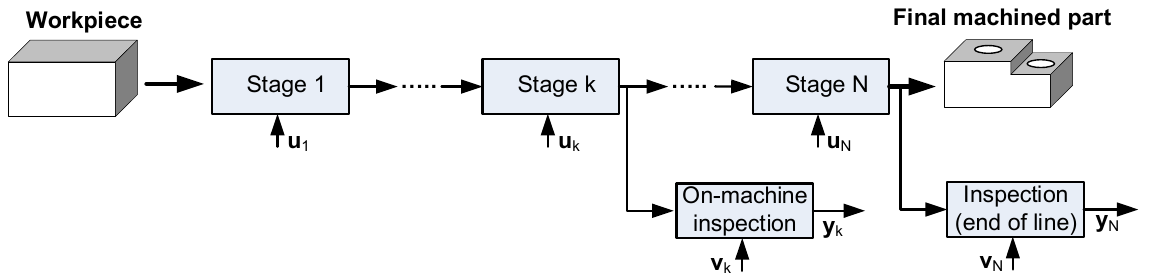
Figure 1. Multistage Manufacturing Process (MMP) with N stages. Notation: variations sources ( u ), measurement noise ( v ), inspection measurements ( y ).